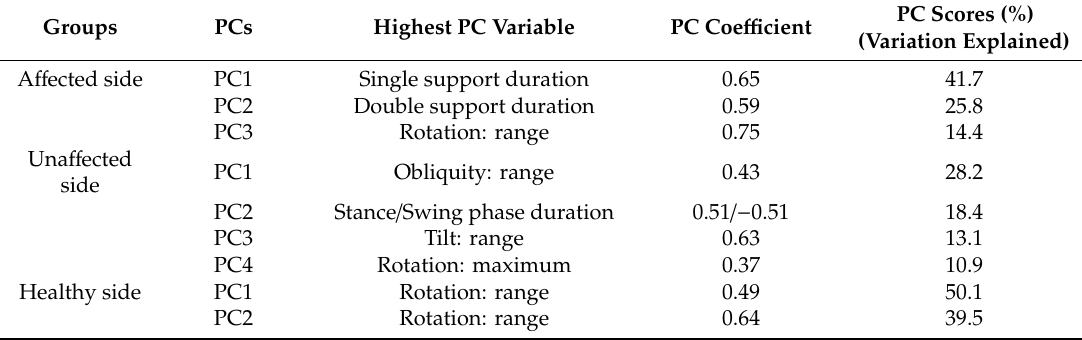
Table 3. Principal component analysis of each